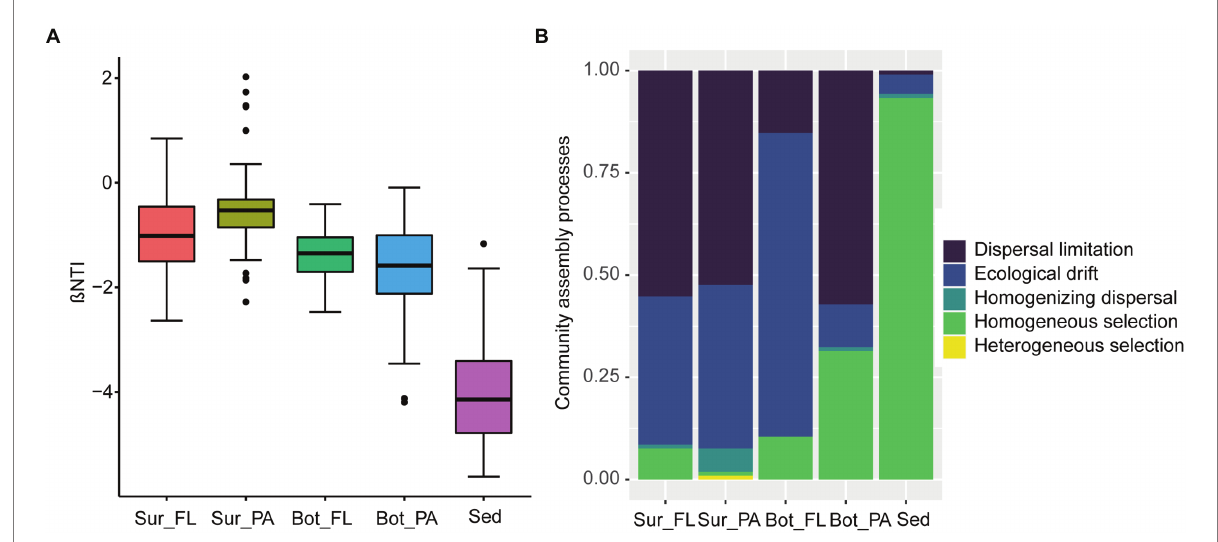
FIGURE 7 Community assembly mechanisms in different communities. (A) β NTI values for different communities; (B) The assembly processes of different communities with the null model.